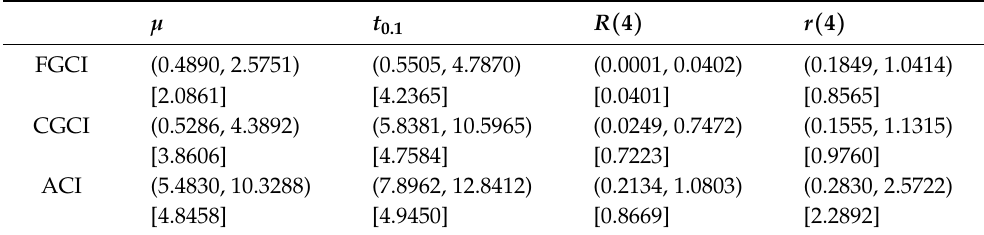
Table 6. Interval and prediction interval estimates using the lung cancer survival data (8). µ t 0.1 R ( 4 ) r ( 4